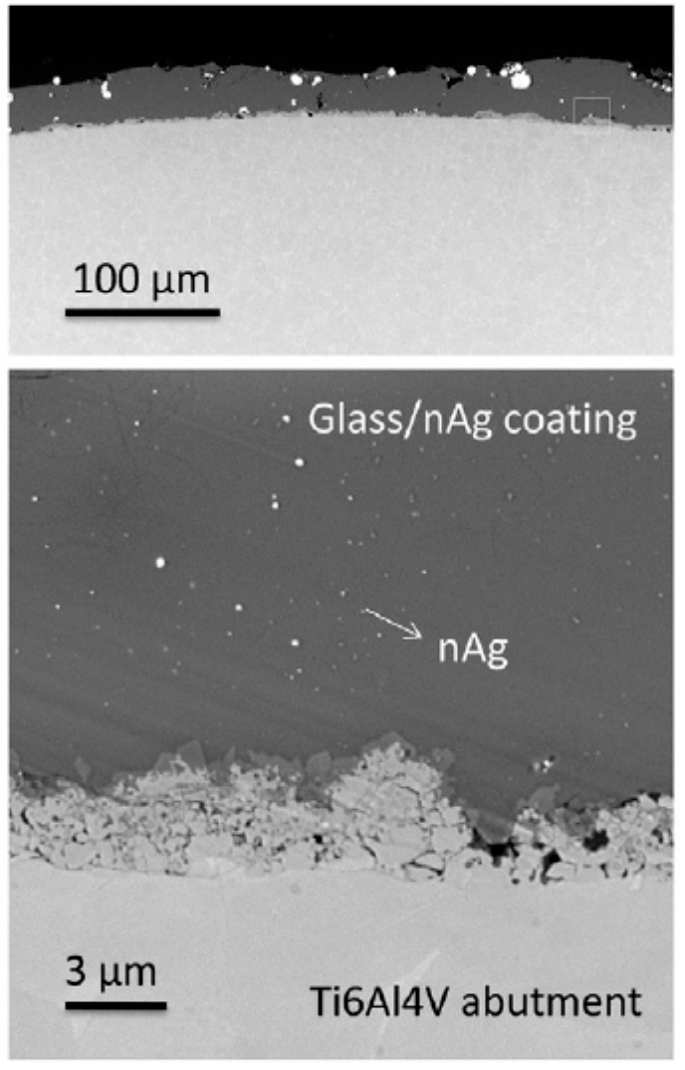
Figure 4. Scanning electron micrographs at different magnifications of a cross-section of the abutment. Reprinted with permission from [44] under a Creative Commons License.